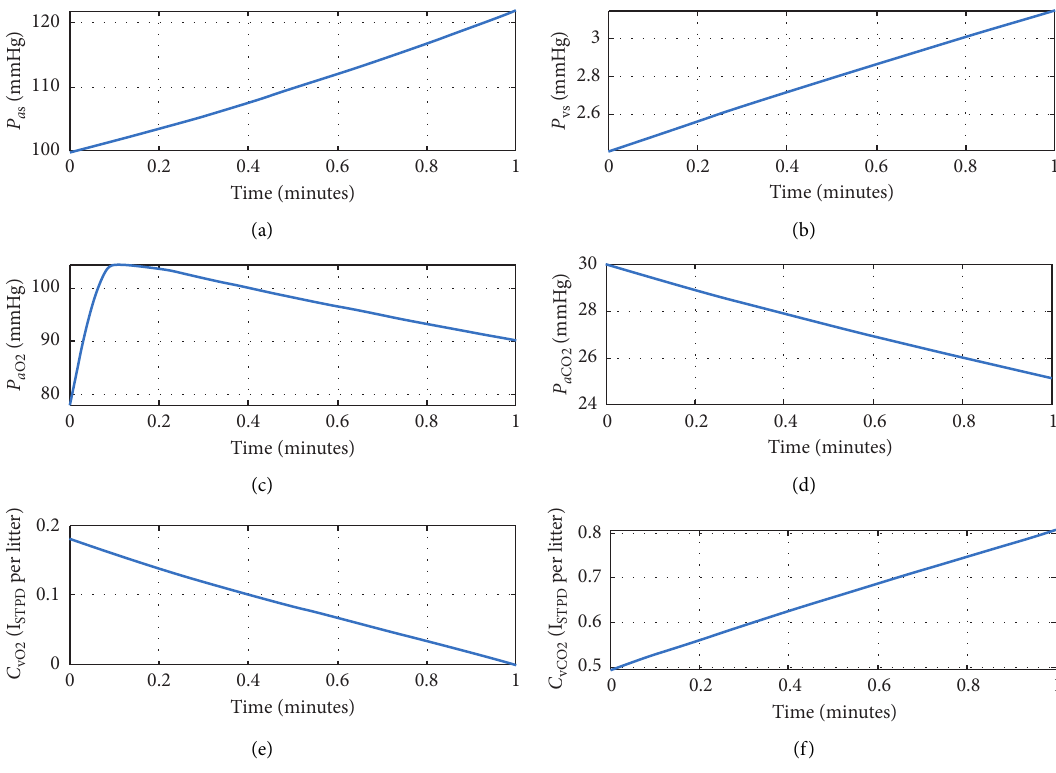
Figure 11: ICRSMM numerical test for a normal patient.